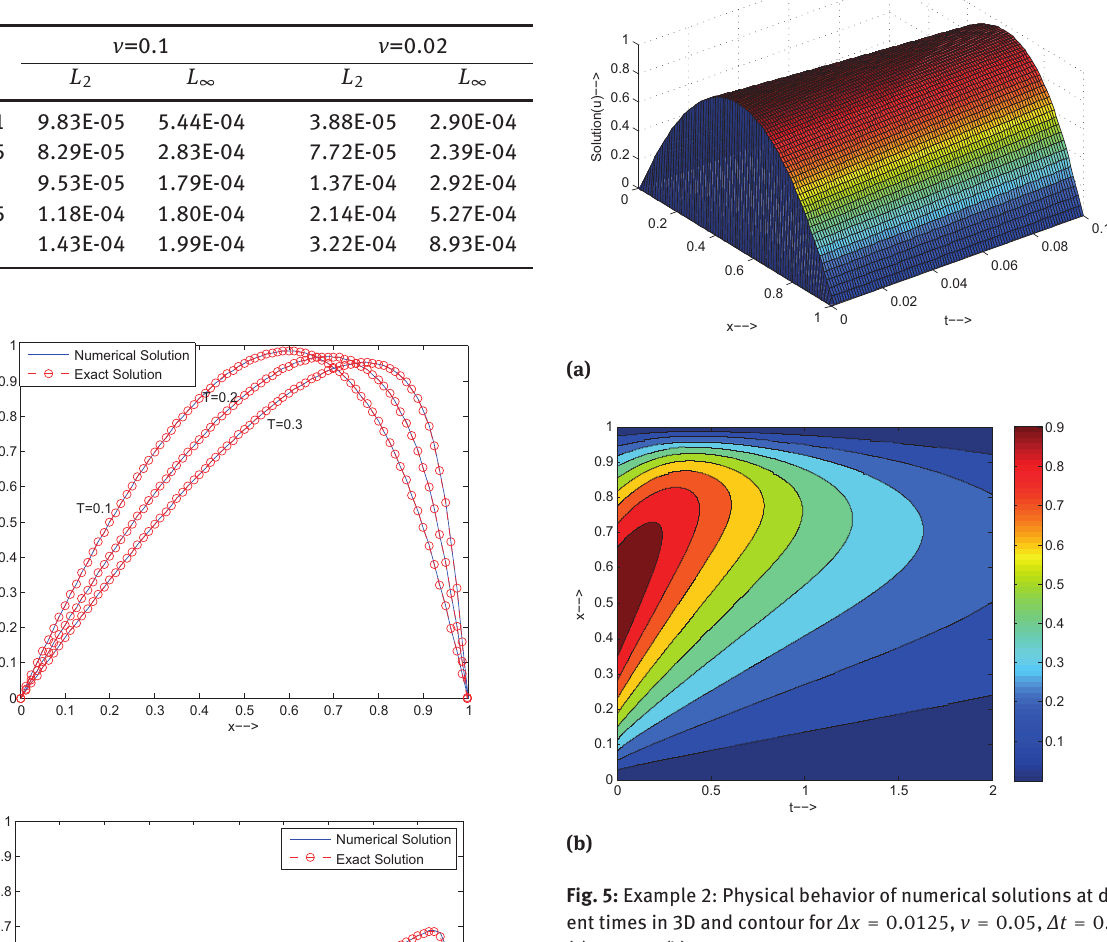
from BDF-2 and BDF-3 lies close to exact solutions.